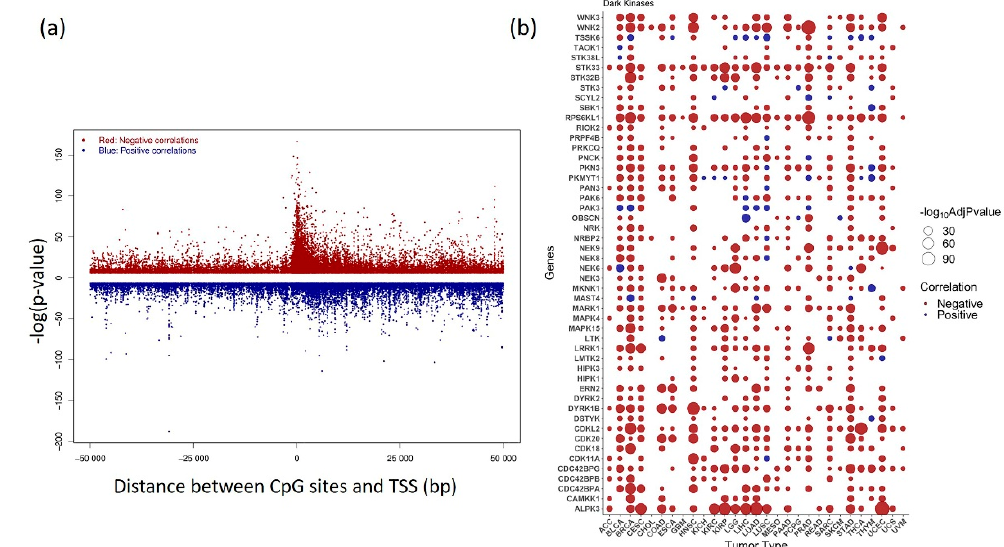
Figure 4. Correlation between kinase gene expression and methylation ( a ) Distribution of pan-cancer positive and negative correlation between DNA methylation β value and gene expression plotted against distance between CpG sites within 50Kb and transcription start site (TSS) ( b ) Bubble plot showing the status of most significant correlations belonging to Dark Kinases group +/ − 1500 bp from TSS obtained at Bonferroni corrected p -value < 0.05. Negative correlations are shown in red and positive correlations are shown in blue. Genes with significant correlation values obtained in > 30% of analyzed cancers are plotted.